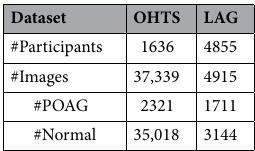
Table 1. Characteristics of the OHTS and LAG